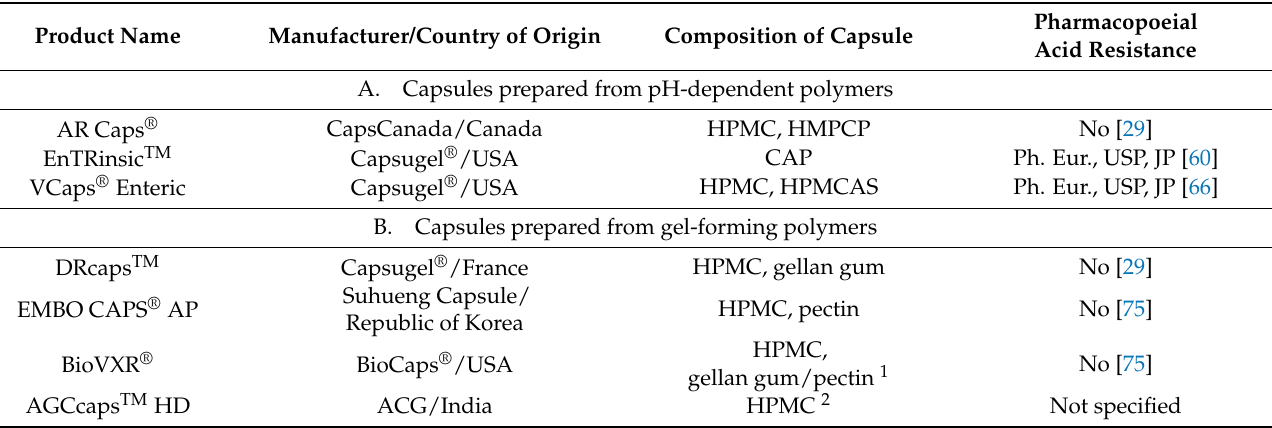
Table 4. Overview of commercially produced capsules using